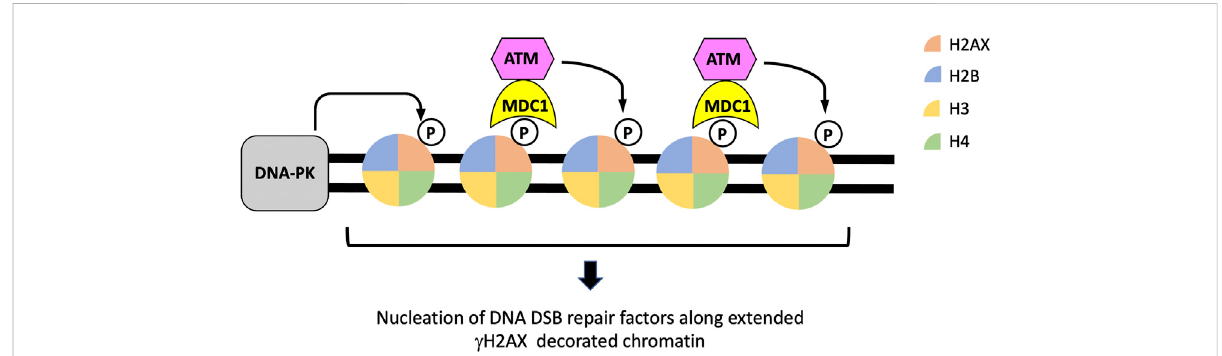
FIGURE 2 The establishment and expansion of γ H2AX along chromatin regions fl anking DSBs. Both DNA-PK and ATM are activated in response to DSBs and can phosphorylate histone H2AX to form γ H2AX in chromatin fl anking DSBs. The binding of the DNA damage response protein MDC1 and its